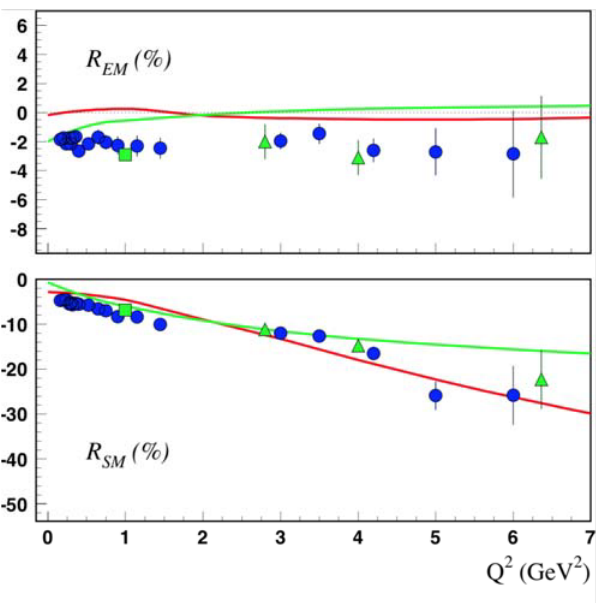
Fig. 14 (Color online) The ratios R EM and R SM for the NΔ (1232) transition. The solid red curves are the LF RQM predictions, the green curves are from the DSE approach. References to data as in Fig. 13.